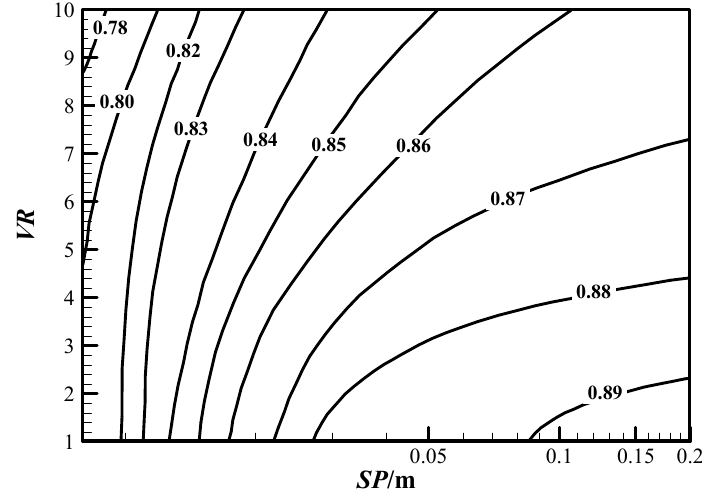
Figure 3. Turbine efficiency map (reproduced from Perdichizzi and Lozza [25]).